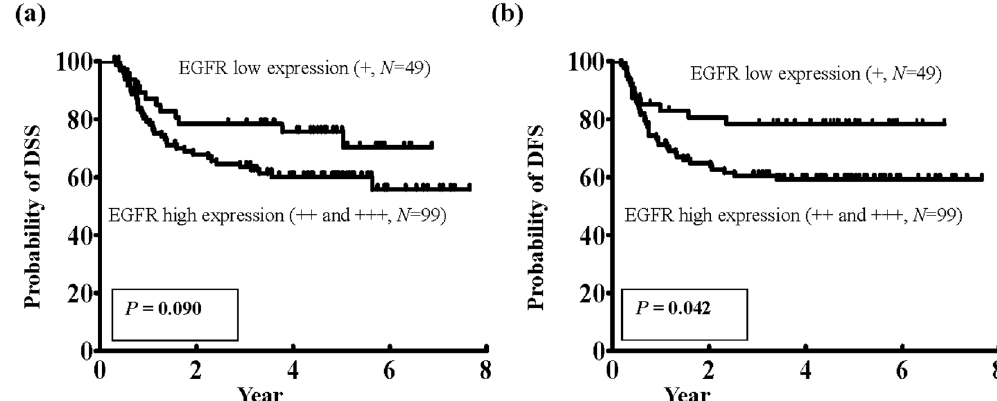
Figure 2. Association between high EGFR expression in the immunohistochemistry analysis and poor prognoses of patient disease-specific survival (DSS) and disease-free survival (DFS). ( a ) Kaplan-Meier plot showing that the 5-year DSS rates in patient subgroups stratified by EGFR expression levels were 74.8% versus 60.1% ( P = 0.090). ( b ) Kaplan-Meier plot showing that the 5-year DFS rates in patient subgroups stratified by EGFR expression levels were 73.8% versus 59.3% ( P =